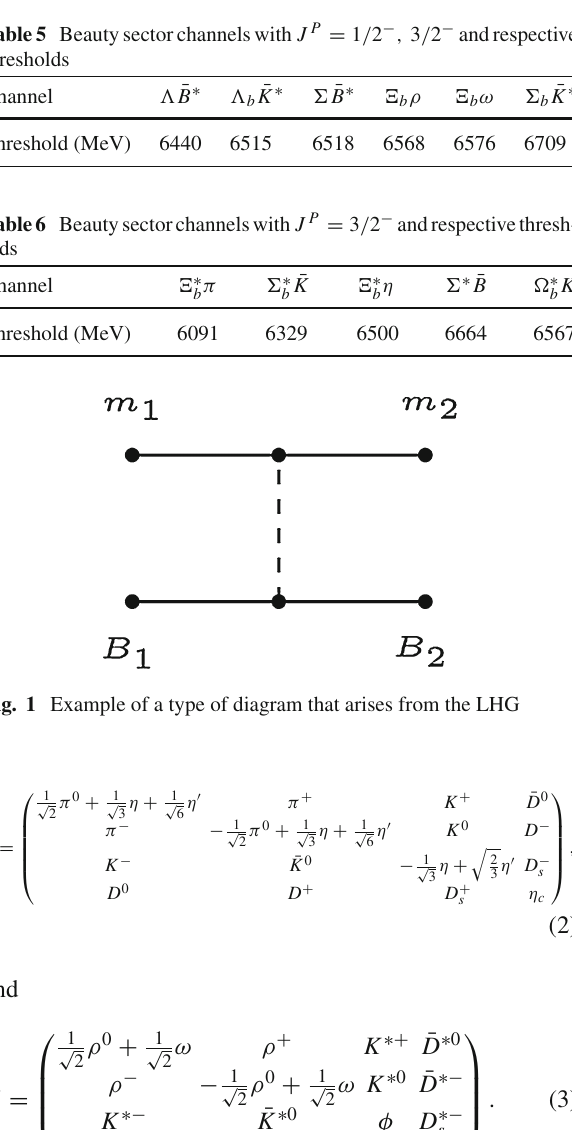
Table 4 Beauty sector channels with J P = 1 / 2 − and respective thresholds